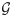
An example of a perfume-note network G.An edge (black lines) is drawn between a perfume (a black dot with the perfume shown above it) and a note (large grey dots with names) only if that note features in the given perfume’s composition.